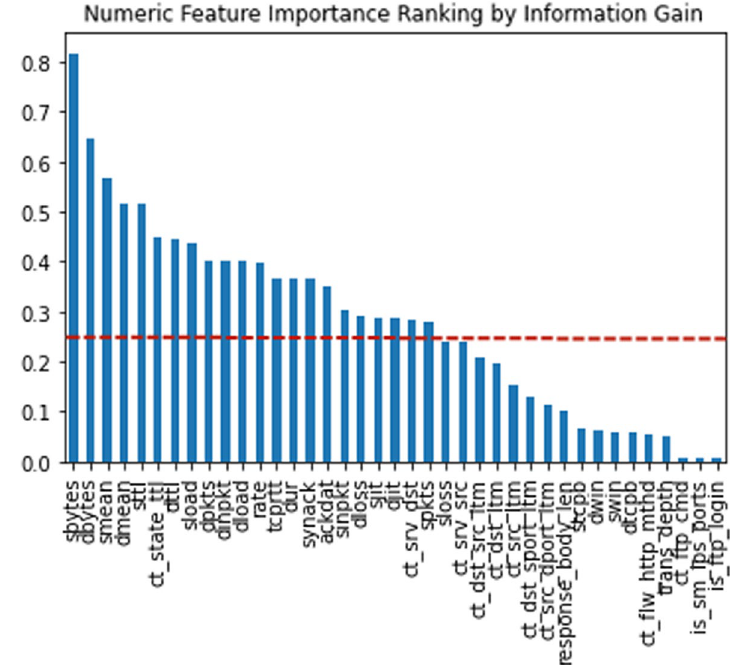
Fig. 8 Numeric feature importance ranking by information